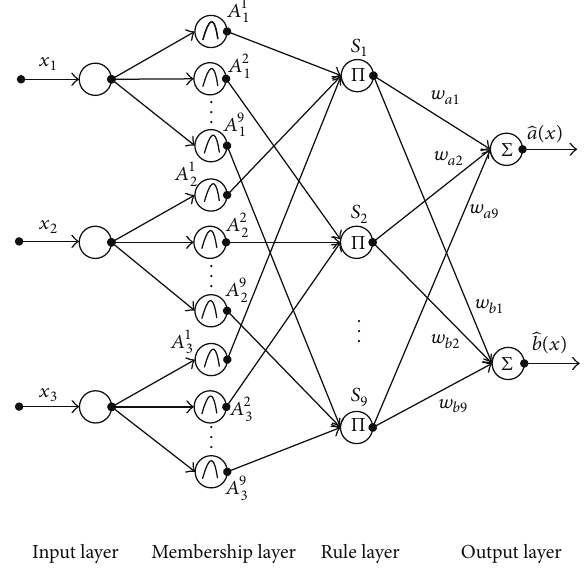
Figure 3: Structure of a fuzzy neural